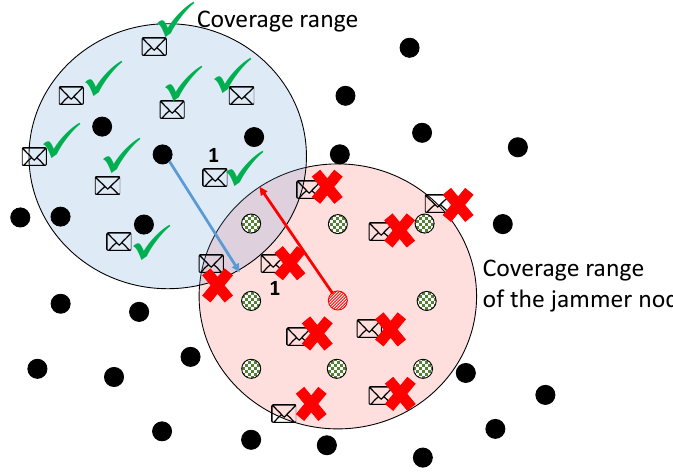
Figure 1. Reactive mechanism for packet